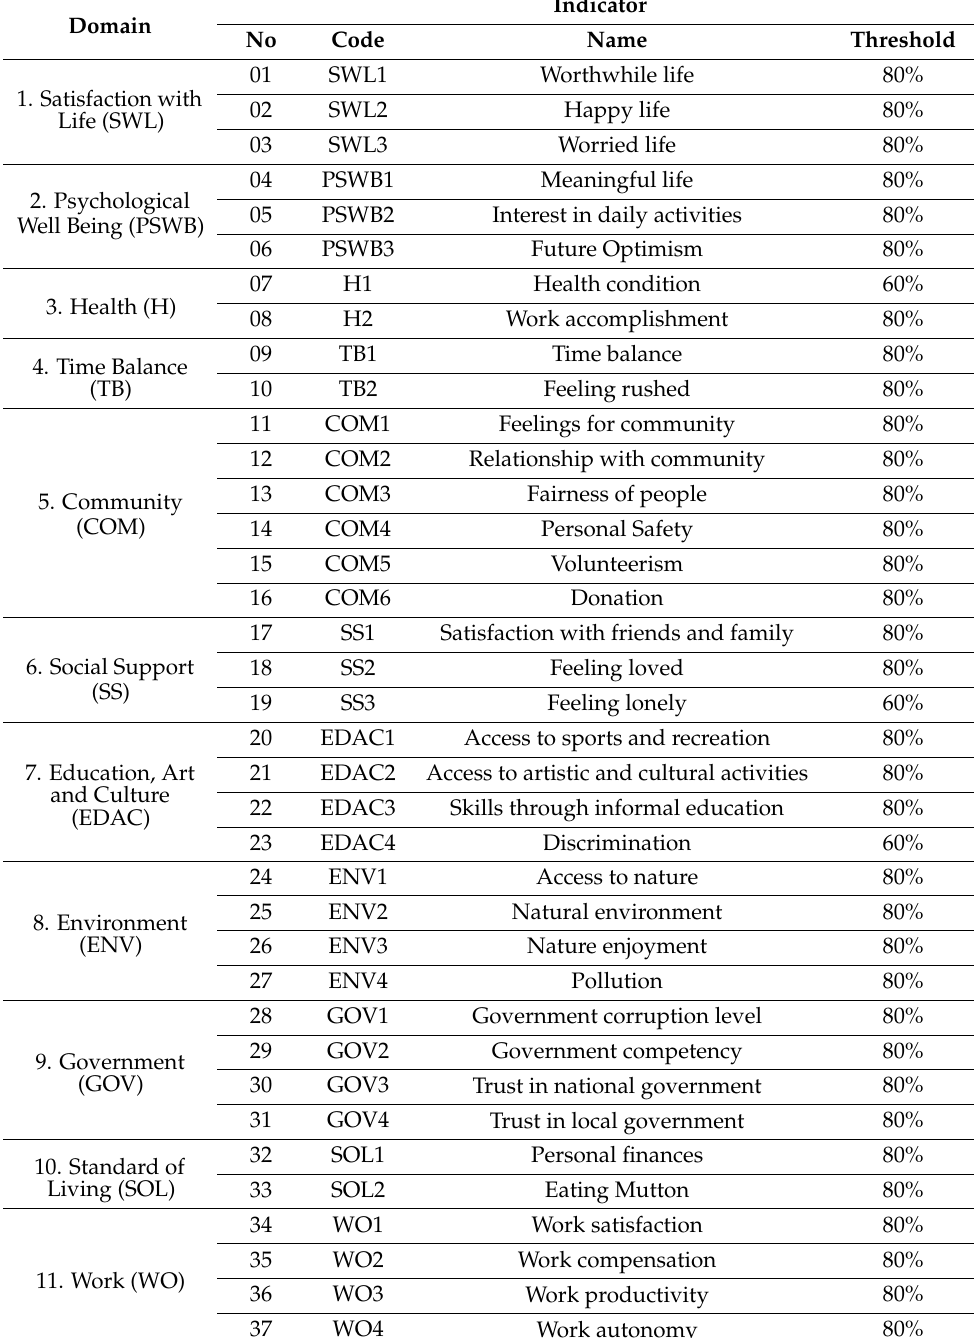
Table 1. Indicator’s code and threshold. Source: Compiled by the